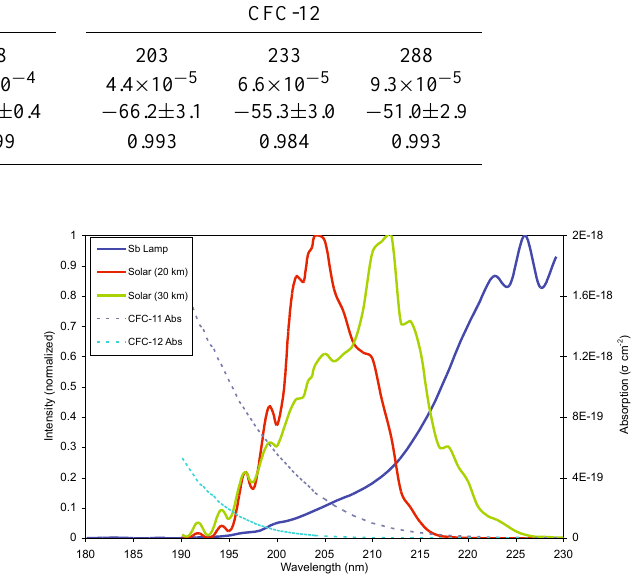
Fig. 2. Normalized UV-C intensity of the Sb lamp and actinic UV-C (Minschwaner et al., 1993) in the altitude range where CFC photol- ysis takes place (19–34km), and absorption spectra for CFC-11 and -12 in the relevant wavelength range.